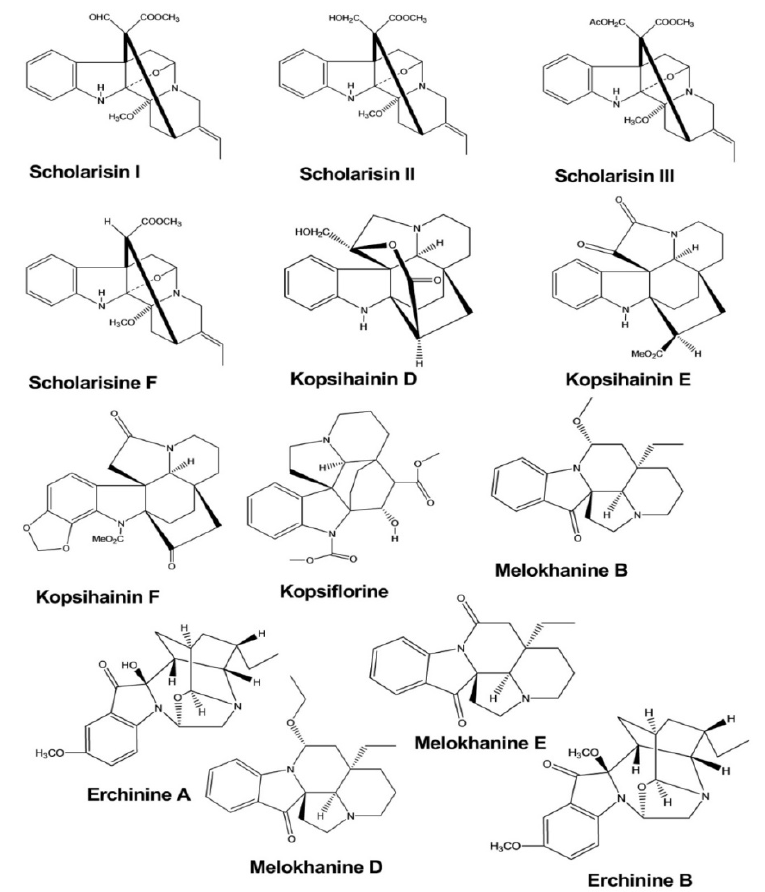
Figure 2. Antimicrobial activity of indole alkaloids.